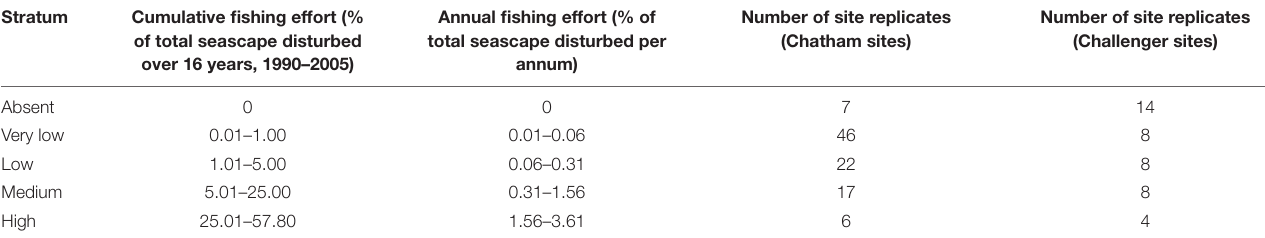
TABLE 2 | Fishing effort classes for Ocean Survey 20/20 Chatham Rise and Challenger Plateau datasets used to compare functional group abundance at site replicates.